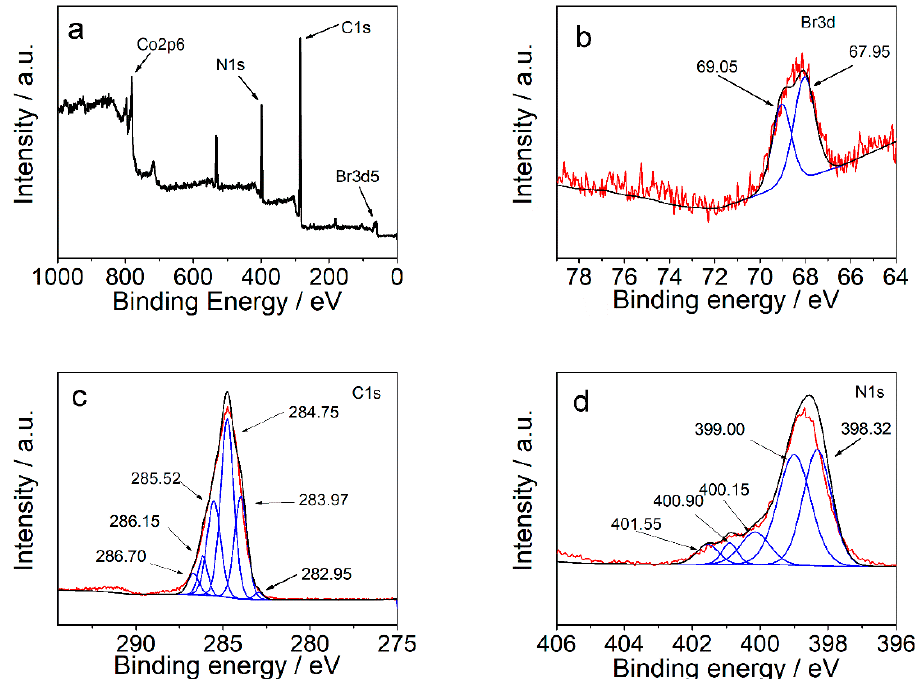
Figure 2. X-ray photoelectron spectroscopy (XPS) spectra of ZIF-67-IL: full survey ( a ), high-resolution spectrum and deconvolution results of Br 3 d 5 ( b ), C 1 s ( c ), and N 1 s ( d ).